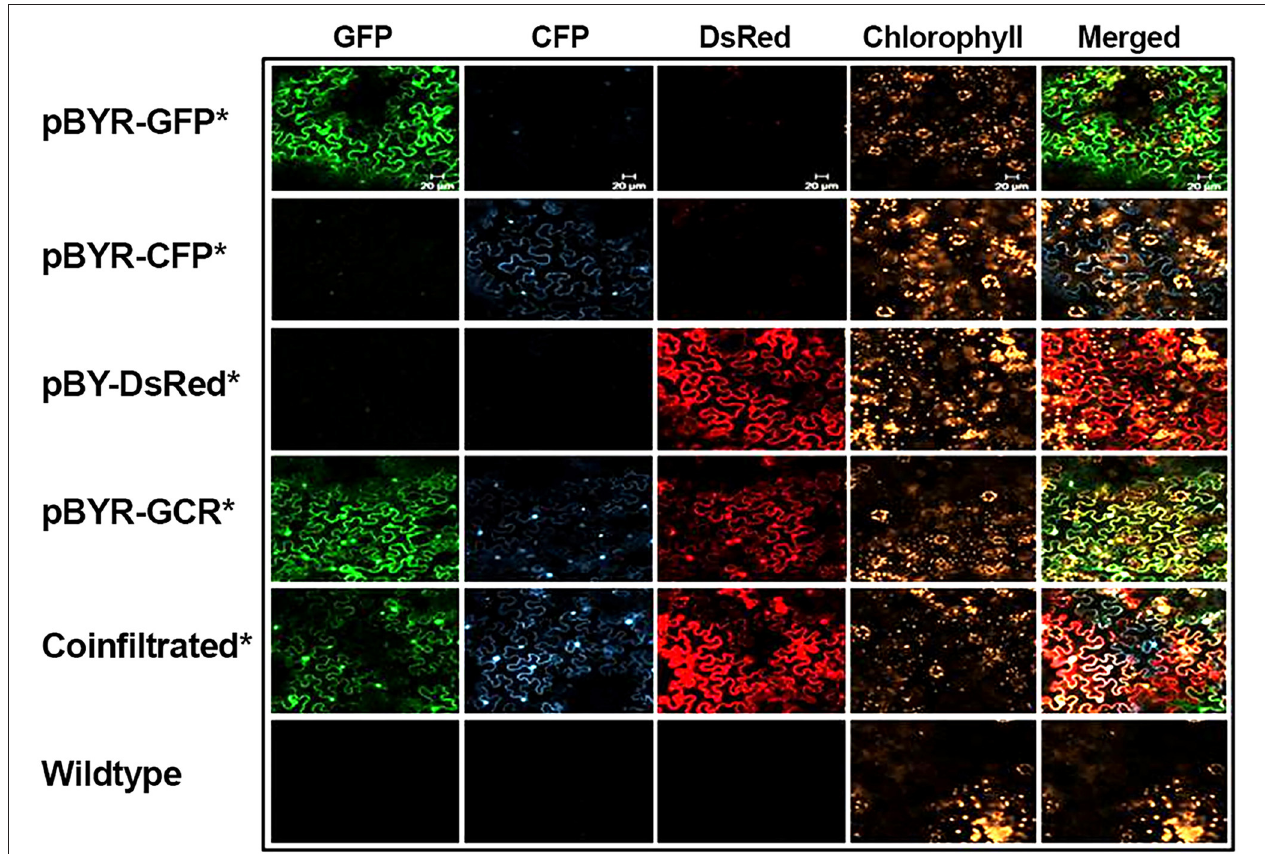
FIGURE 4 | Simultaneous co-expression of three fluorescent proteins. N. benthamiana leaves were infiltrated with Agrobacterium strains harboring expression vectors as indicated (on the left). At 2 DPI the infiltrated leaf samples were examined with confocal laser scanning microscope. For co-infiltration, mixture of Agrobacterium strains harboring pBY-GFP, pBY-CFP, and pBY-DsRed were used. Excitation lasers of 488, 458, and 543nm and detection windows of 550–560, 470–500, and 614–646nm were employed to detect GFP, CFP, and DsRed signals, respectively. For plant autofluorescence chlorophyll detection, the excitation laser of 633nm with detection window of 630–700nm was